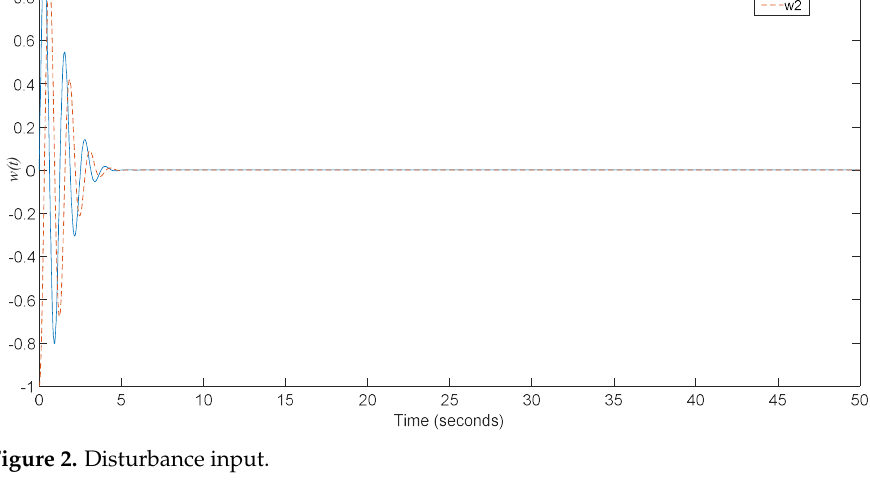
Figure 2. Disturbance input.